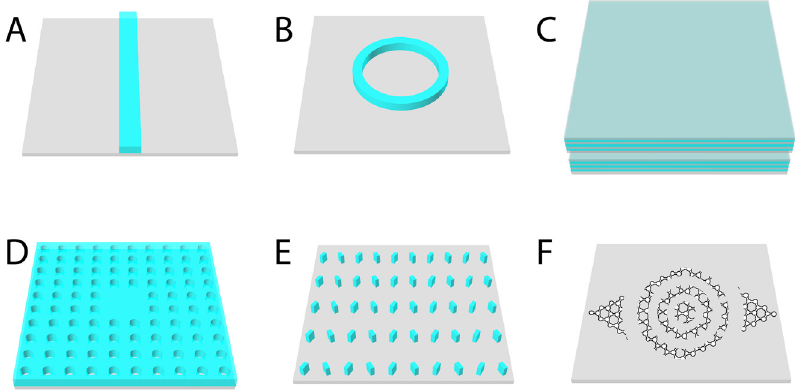
Figure 1: Photonic environments for